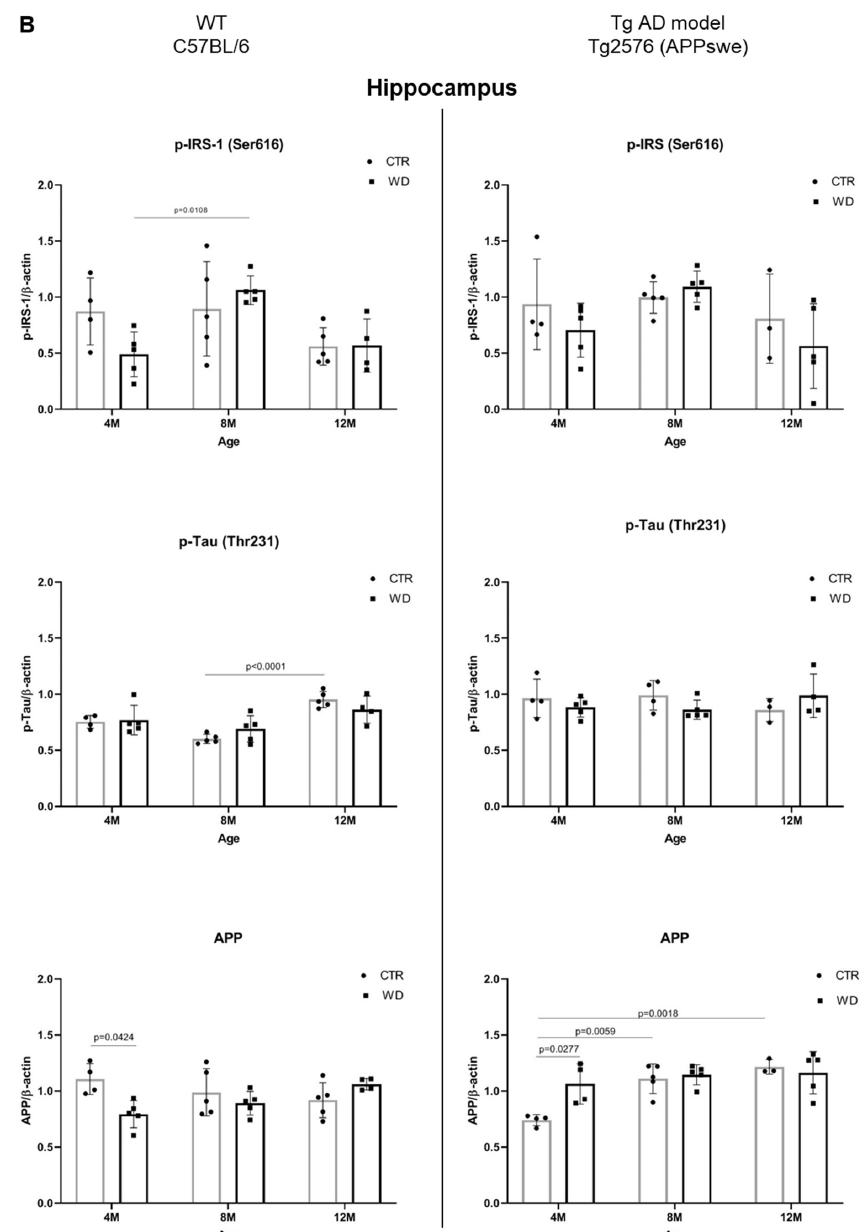
Figure 6. ( A ). Quantitative analysis of the levels of insulin resistance and AD markers in entorhinal cortex—comparison of the AD model Tg2576 (APPswe) and wild-type C57BL/6J. Statistical analysis comprised the Shapiro–Wilk normality test, two-way ANOVA, and Tukey’s post hoc test; significant results: WT C57BL/6 p-IRS-1 (Ser616): (4M WD vs. 8M WD ( p -Value = 0.0042); 4M WD vs. 12M WD ( p -Value = 0.0016); 12M CTR vs. 12M WD ( p -Value = 0.0084); Tg2576 (APPswe) p-Tau (Thr231): (4M